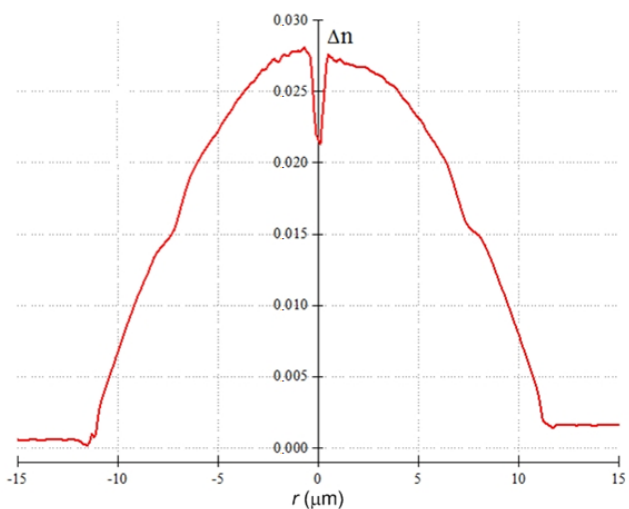
Figure 4. LOMF 100/125 preform refractive index profile.